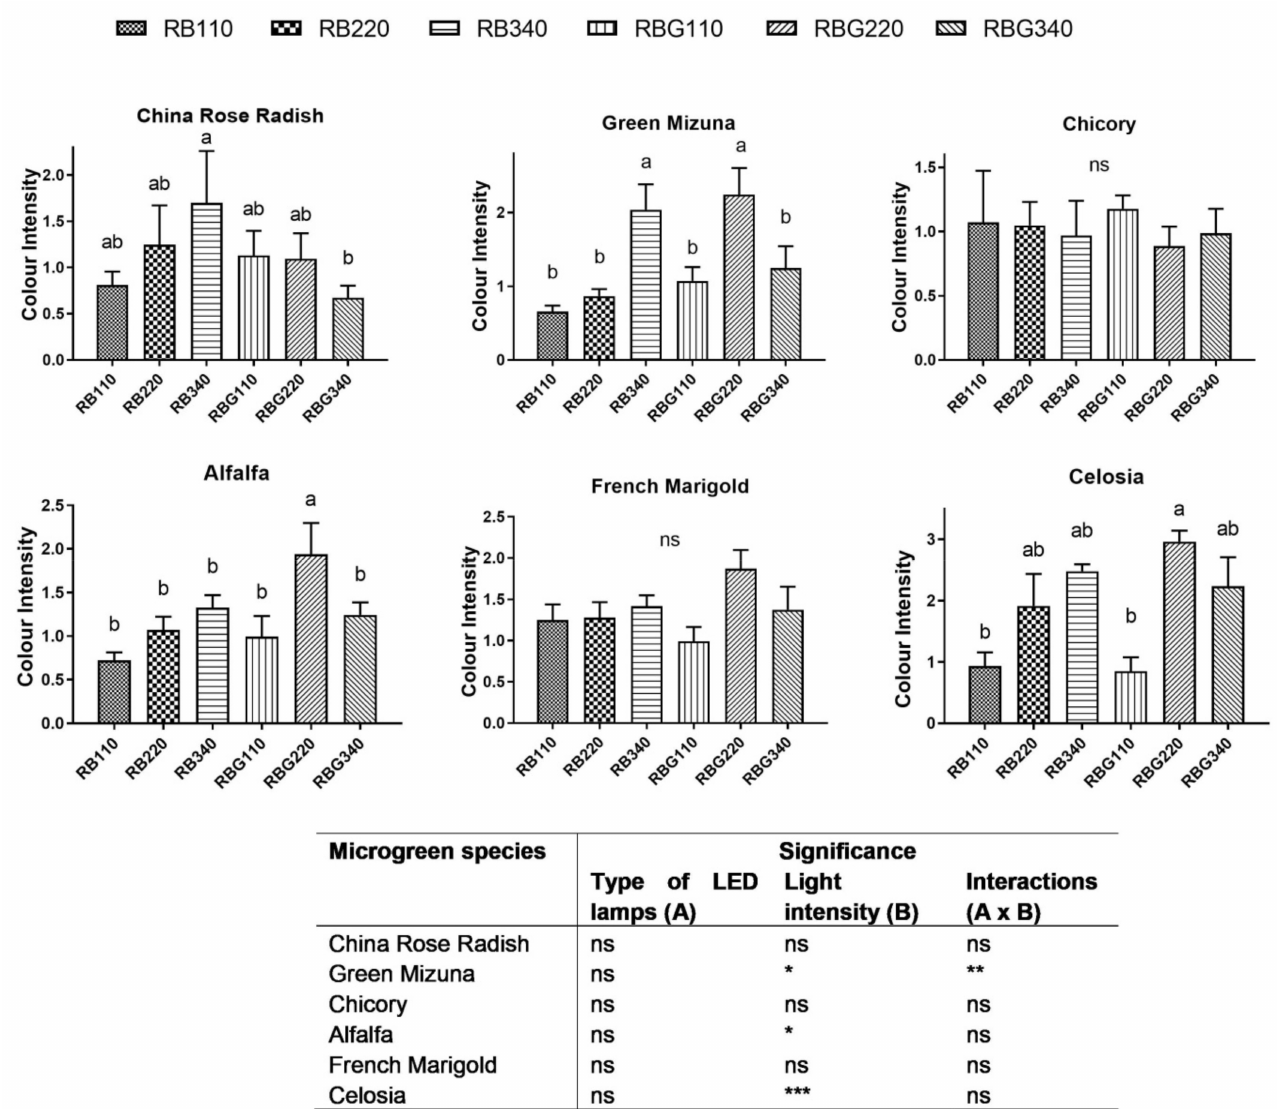
Figure 6. Chroma index from the six microgreen species affected by different light environments. Data are shown as means with at least five independent biological replicates and error bars indicate standard error (SE). Data were subjected to two-way analysis of variance and differences were analyzed by Tukey’s post-hoc. Different letters denote significant differences at p < 0.05. Levels of significance of the parameters assessed for each microgreen species considered where: ns, *, **, *** are not significant, significance at p < 0.05, 0.01, 0.001, and 0.0001 respectively. When there was not significant A × B interaction, the effect of light spectra (A) and light intensity (B) was evaluated separately using one-way ANOVA and t -test, respectively (Supplementary Table S1). Different letters on the histograms within each light spectrum (RB and RGB) indicate significant differences among light intensities (Tukey’s test, p <